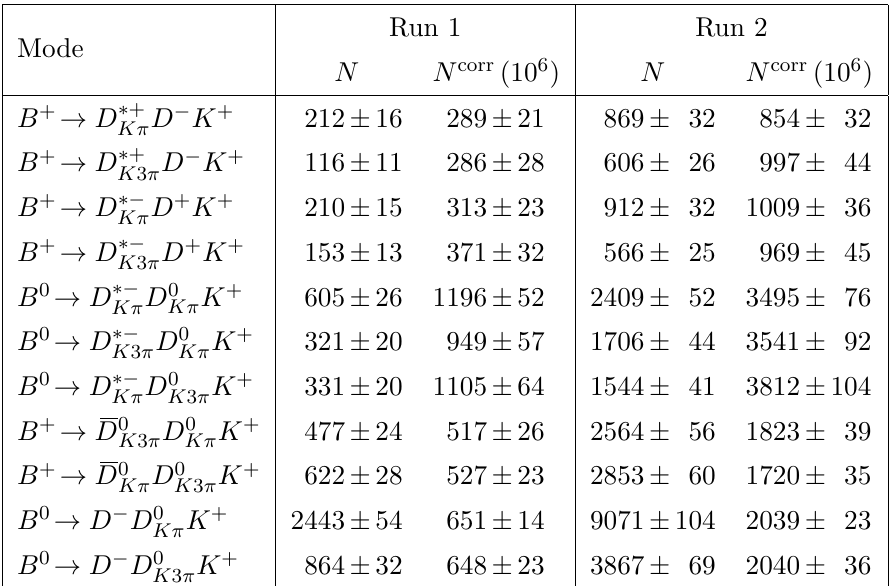
Table 2 . Table of all signal yields N and efficiency and D -meson branching fraction corrected yields N corr with the residual peaking background subtracted. The values of corrected yields are rounded to the order of 10 6 . The uncertainties are statistical